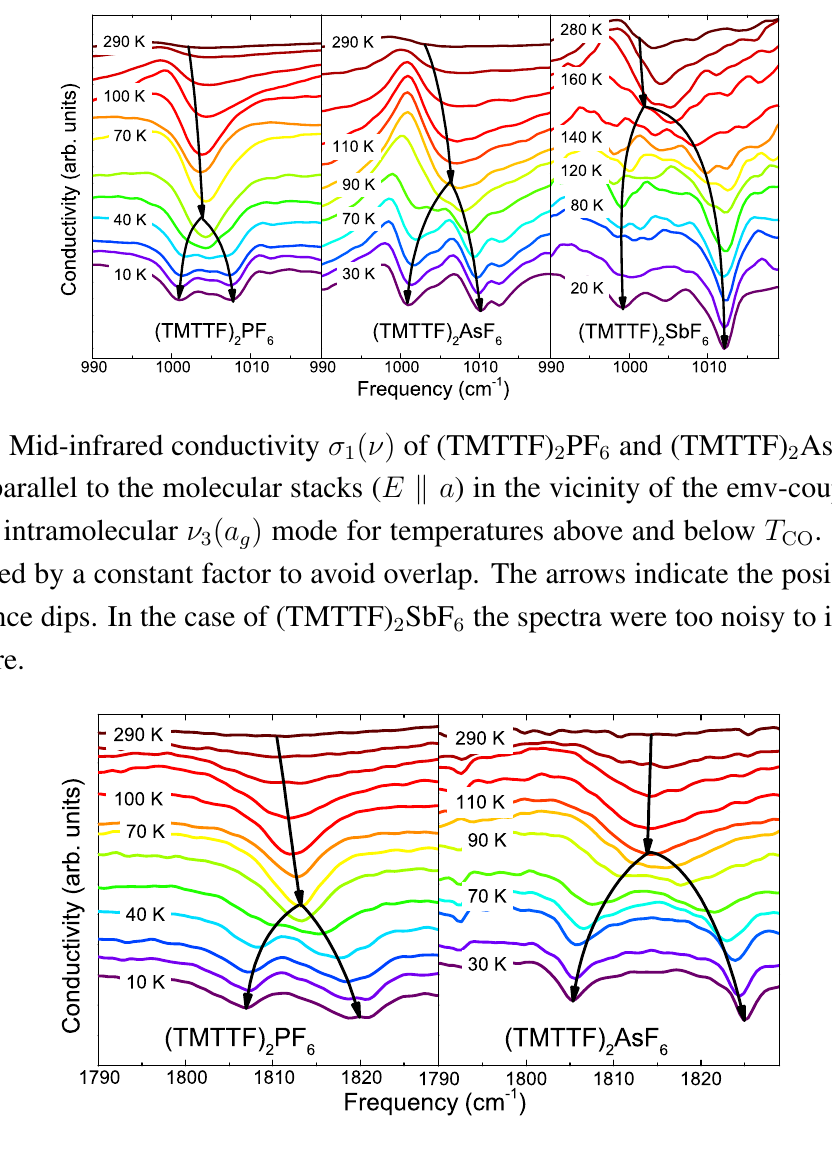
Figure 20. Temperature-dependent infrared spectra for the 2 ν (TMTTF) PF , (TMTTF) AsF and (TMTTF) 2 6 2 6 evolution of the resonance with decreasing temperature.